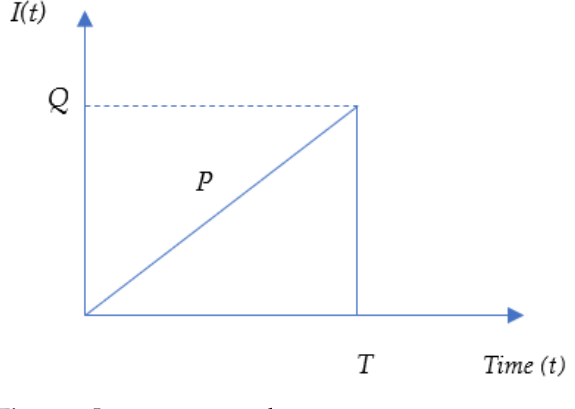
Figure 2. Inventory per